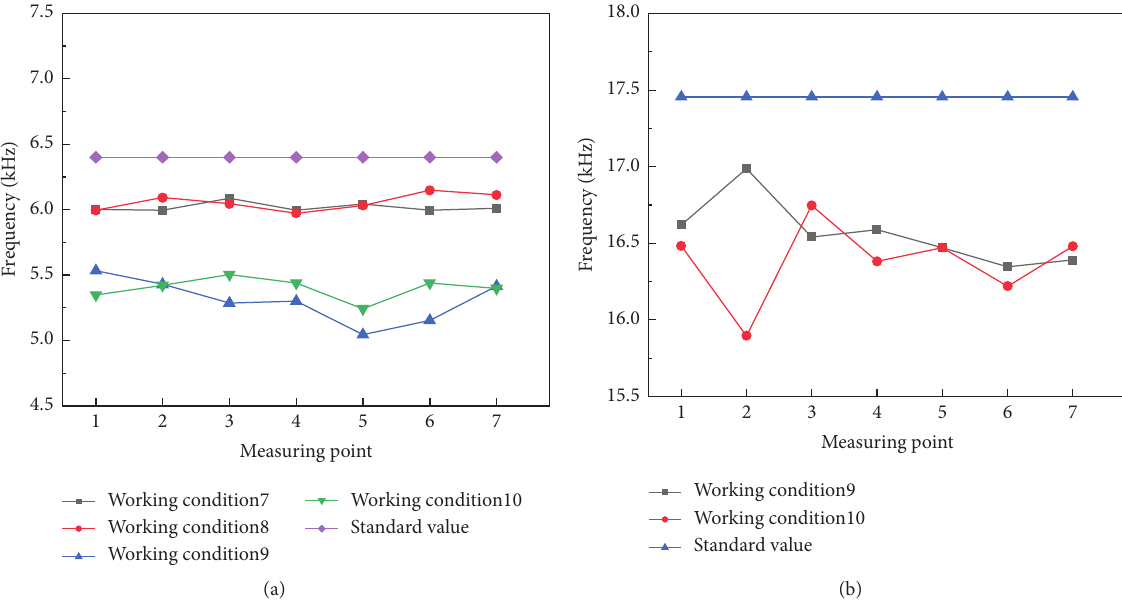
Figure 7: Frequency diagram of measuring points on the 3# board. (a) Board thickness frequency chart. (b) Defect frequency